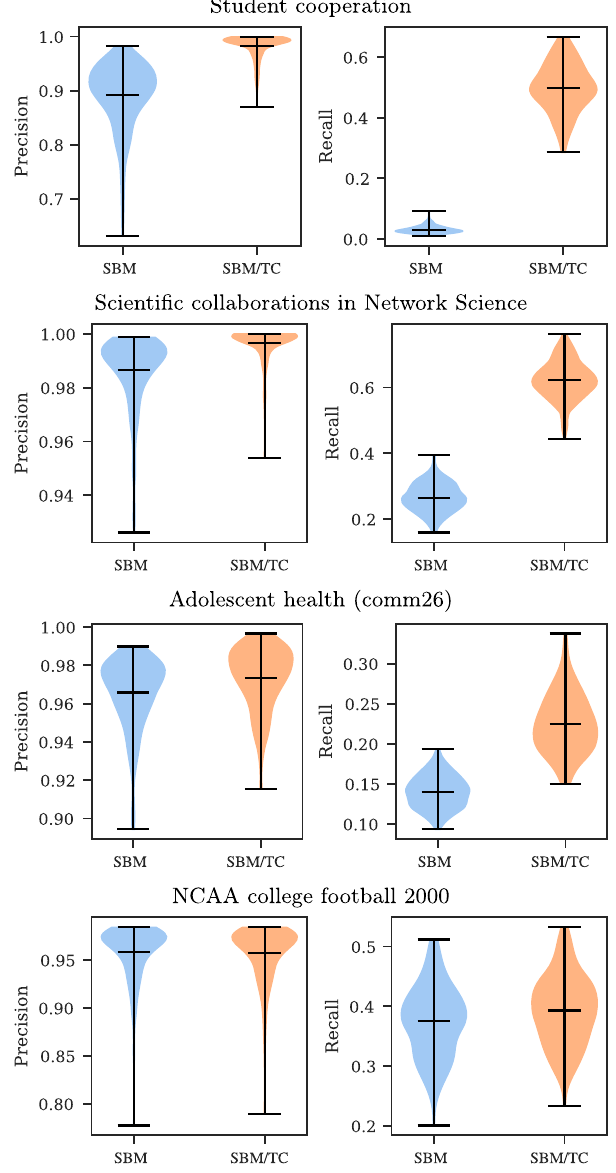
FIG. 10. Distributions of precision and recall values, according to the SBM and SBM/TC models, for four empirical networks, and a fraction f ¼ 0 . 05 of omitted edges and the corresponding number of omitted nonedges. The results were obtained for 200 different realizations of missing edges and